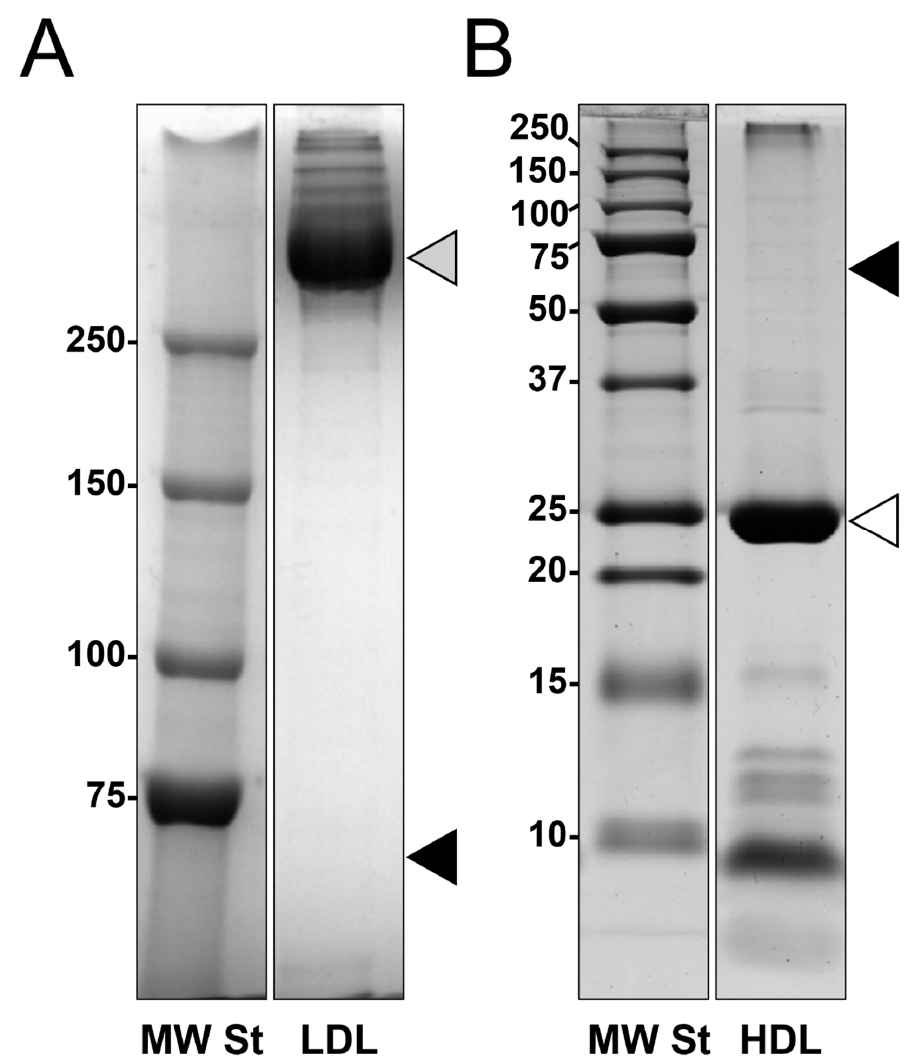
Figure 1. Representative mono-dimensional profiles of both LDL (panel A ) and HDL (panel B ) fractions purified by isopycnic salt gradient ultracentrifugation followed by a further ultracentrifugation step. Fractions were desalted and concentrated using centrifugal filter units with 10 KDa cut-off and resolved by SDS-PAGE in 5% T (panel A ) or 15% T (panel B ) gels. Grey arrowhead indicates the apolipoprotein B100 band (>550 kDa MW) (panel A ), and white arrowhead indicates the apolipoprotein AI band ( ≃ 28 kDa MW) (panel B ). In both panels, the black arrowheads indicate where the albumin ( ≃ 66 kDa MW) band would be located.